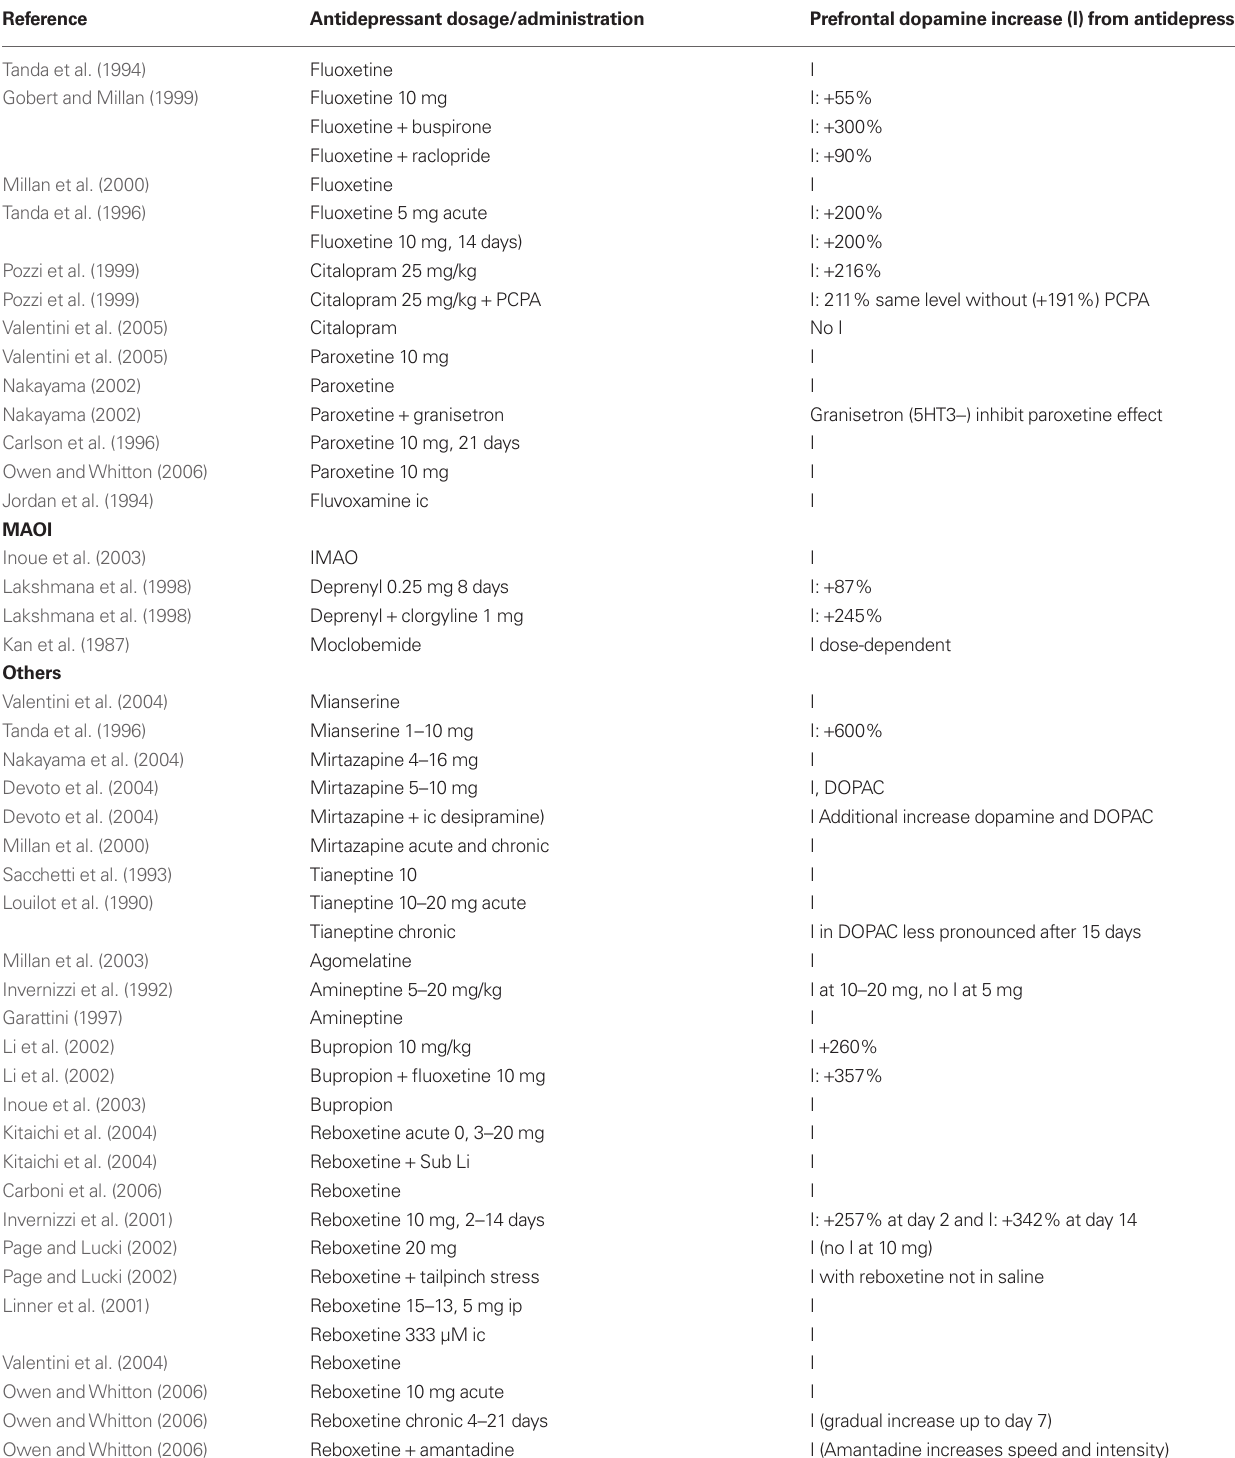
Table 1 indicates that all ADTs, irrespective of their mechanism of action, (electroconvulsive therapy, repetitive transcranial mag- netic stimulation, sleep deprivation, and all chemical class of